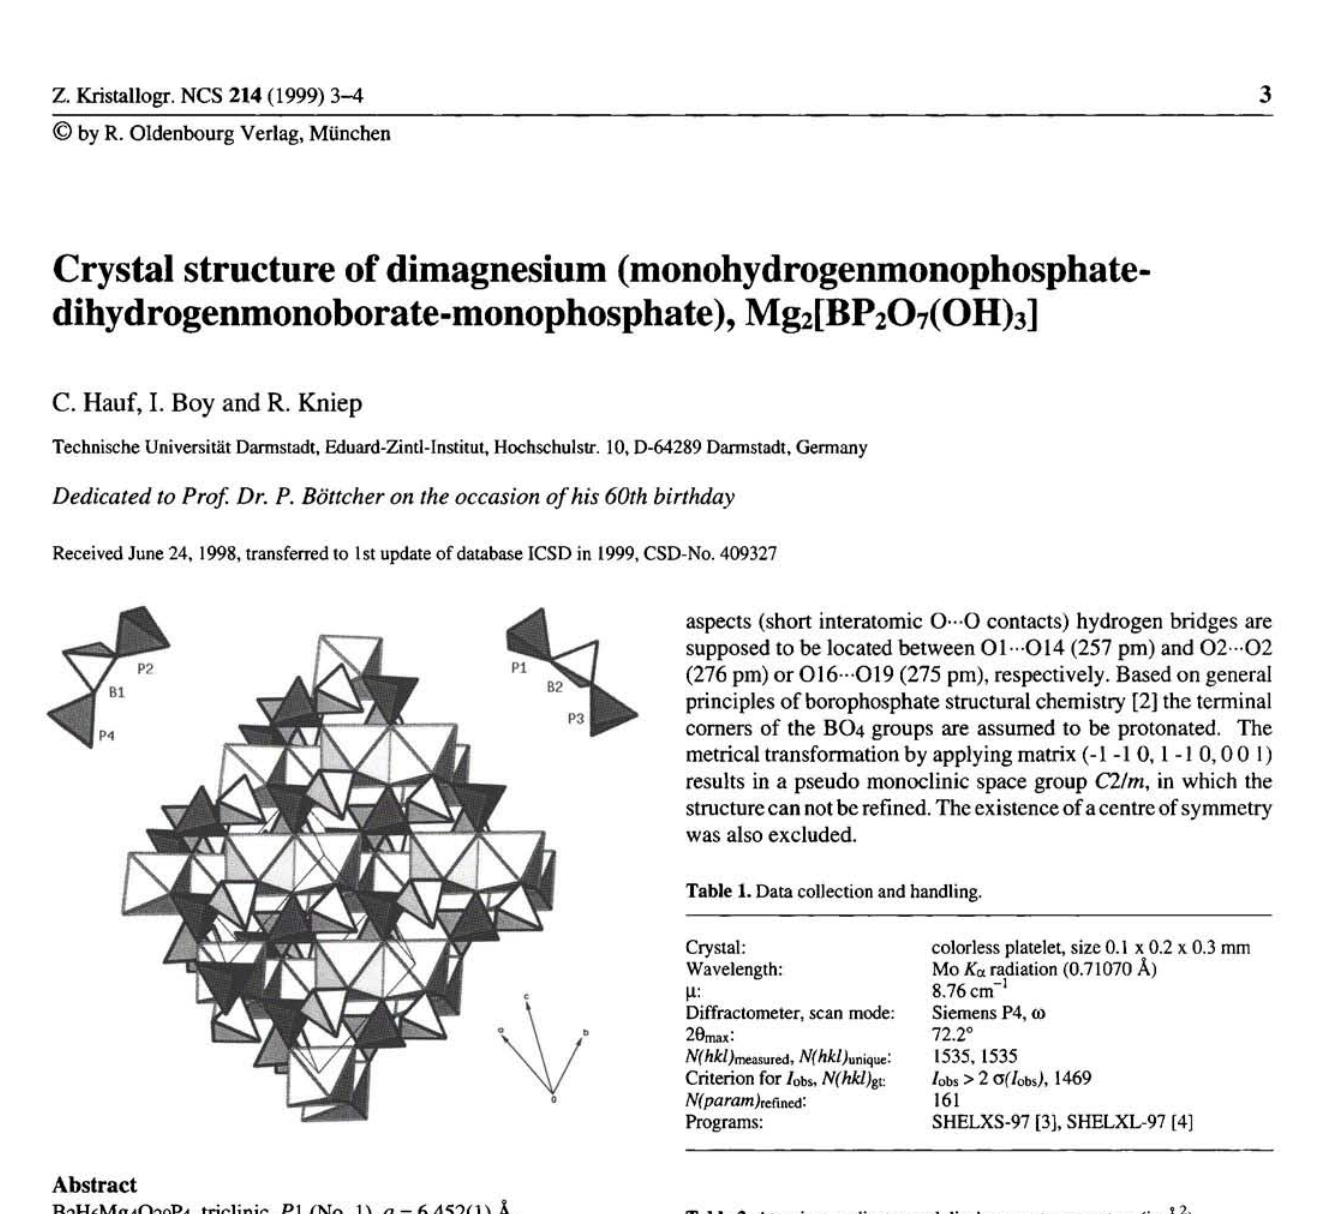
Table 2. Atomic coordinates and displacement parameters (in Â 2